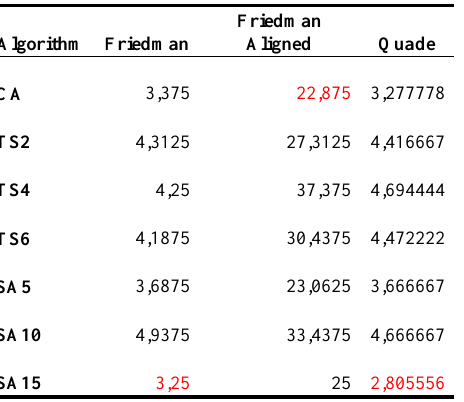
Table 6: Results for D-10. Table 7: Results for D-30.